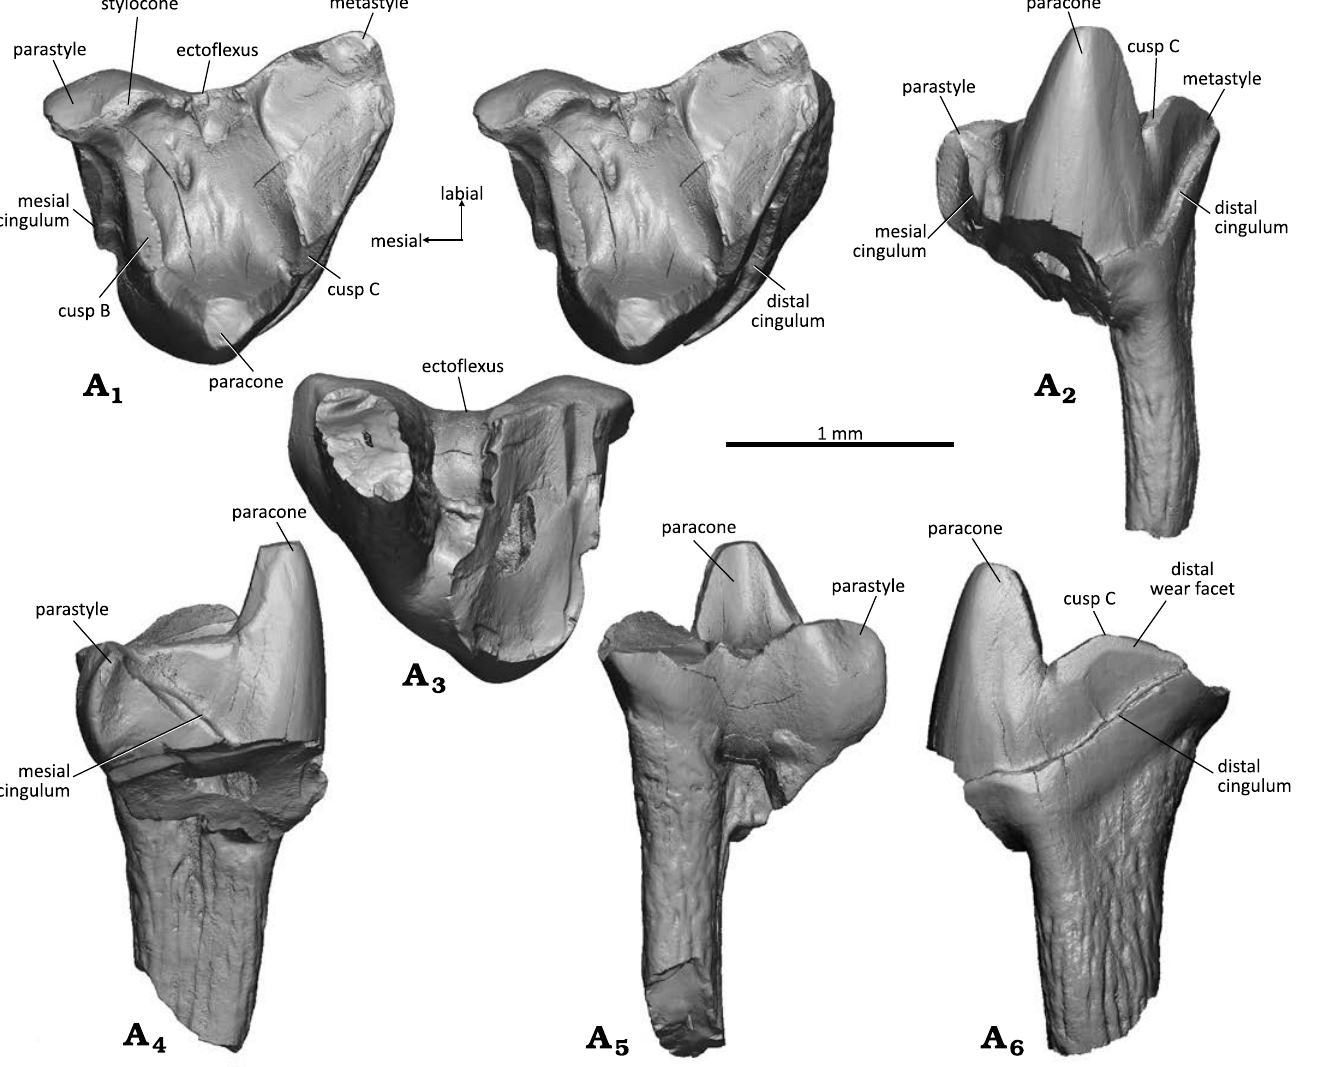
Fig. 4. Spalacotheriid mammal Cifellitherium suderlandicum gen. et sp. nov., WMNM P82302 from Busche Quarry near Balve, North Rhine-Westphalia, Germany, Barremian–Aptian (Lower Cretaceous). Right upper molar in occlusal (stereopair, A 1 ), lingual (A 2 ), dorsal (A 3 ), mesial (A 4 ), labial (A 5 ), distal (A 6 )